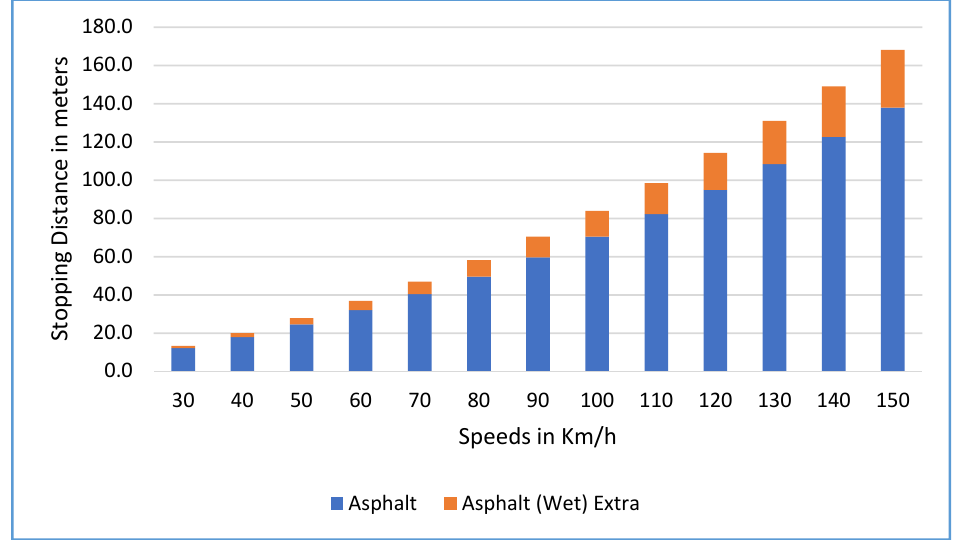
Figure 9. Extra stopping distance in meters on wet asphalt road compared to dry asphalt road for different speeds.